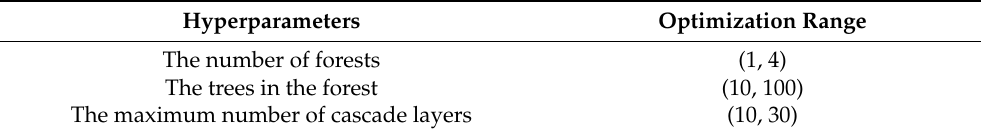
Table 5. The optimization range of hyperparameters in the DF